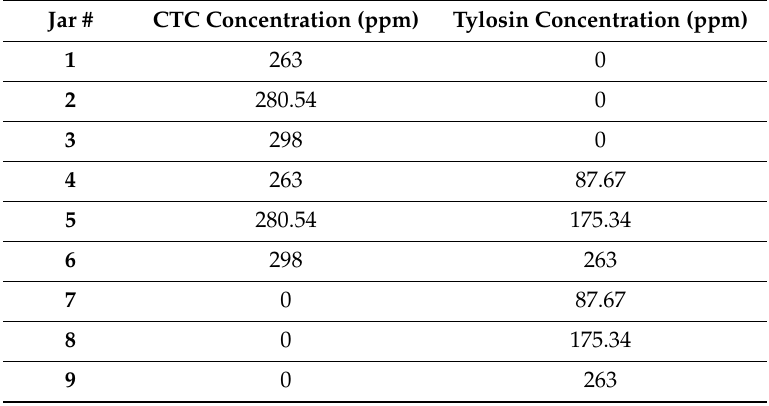
Table 3. Veterinary antibiotics (VAs) concentration spiked in each reactor.